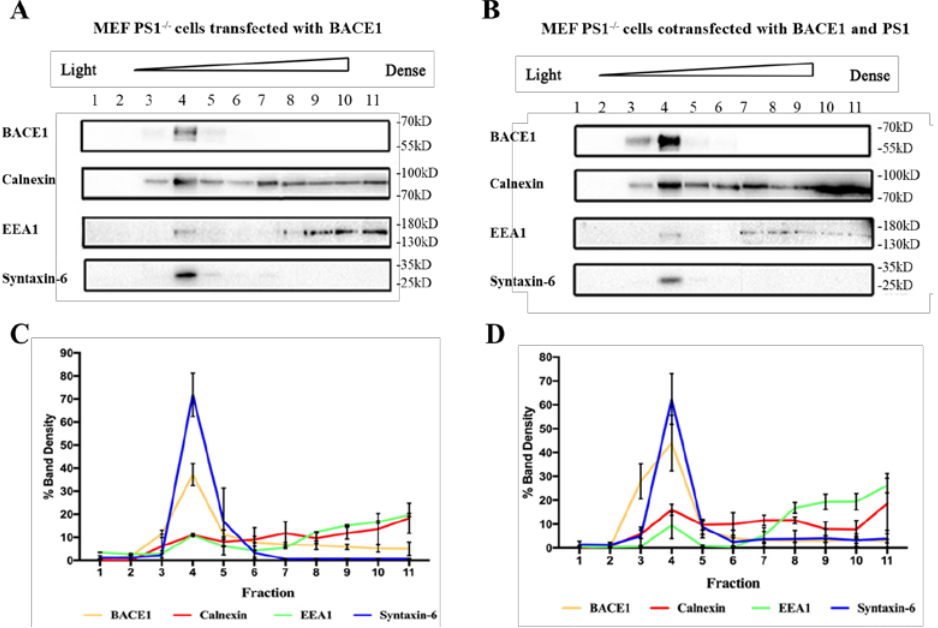
Figure 2. The effect of PS1 on BACE1 subcellular fractionation in MEF PS1 − / − cell. Western blotting of samples after sucrose density gradient centrifugation with transient transfection of BACE1 ( A ) or cotransfection of pBACE1 and pPS1 ( B ). Their quantitative analyses are shown in ( C ) and ( D ), respectively. The Y-axis represents the percentage of target protein in one fraction against total fractions ( n =